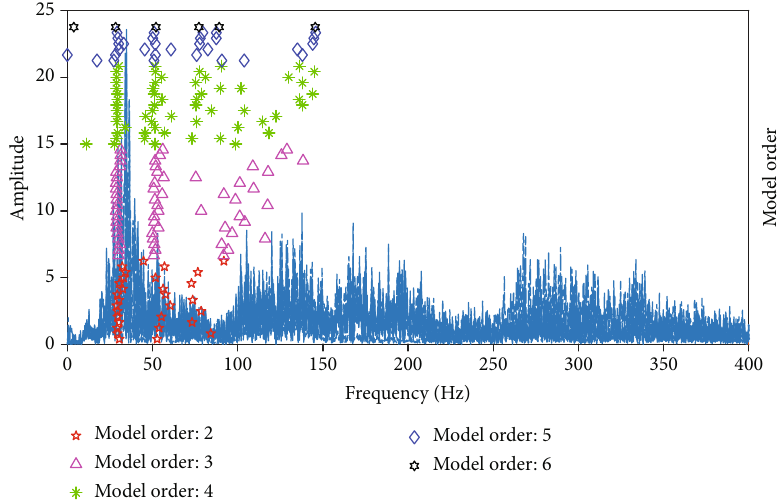
Figure 9: Natural frequency estimates and FFT spectra of experimental acceleration